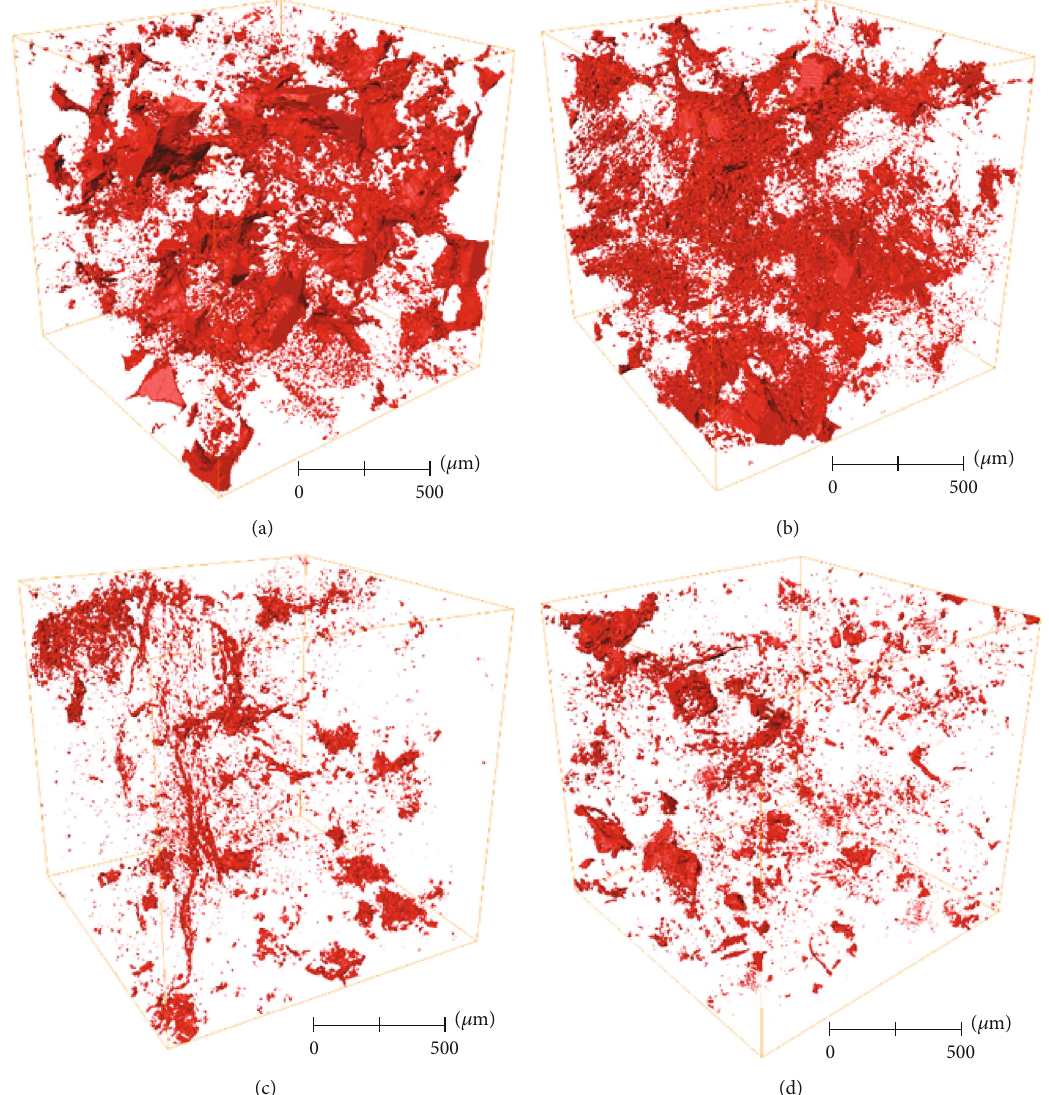
Figure 2: 3D pore model of micro-CT scanning and fractal dimensions for four typical sand conglomerate rock samples: (a) M5-4, fractal dimension = 2 : 66 ; (b) B64-33, fractal dimension = 2 : 64 ; (c) B64-49, fractal dimension = 2 : 21 ; (d) M101-1, fractal dimension = 2 : 20 . Panel (b) was presented in our previous paper